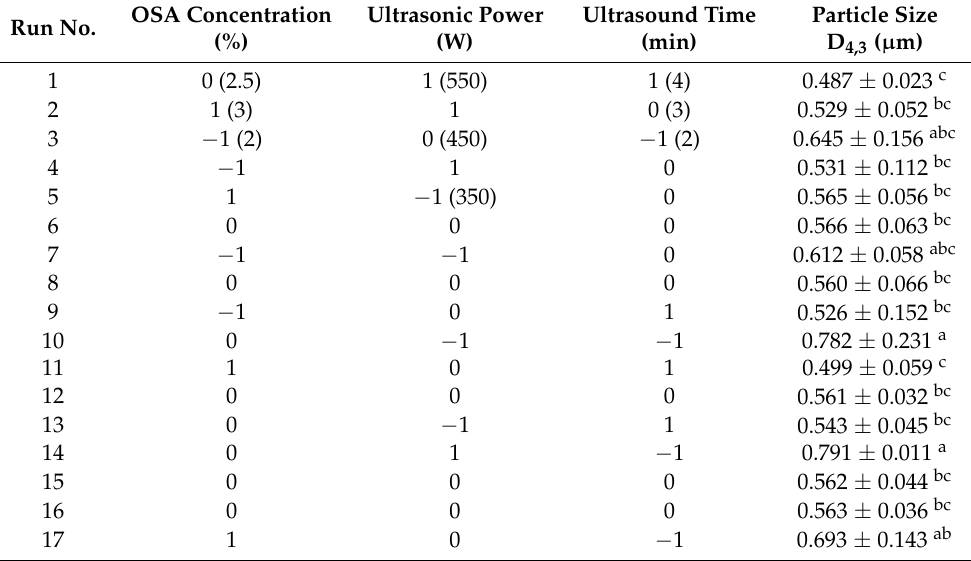
Table 5. Experimental points of the Box Behnken design and the experimental data. Run